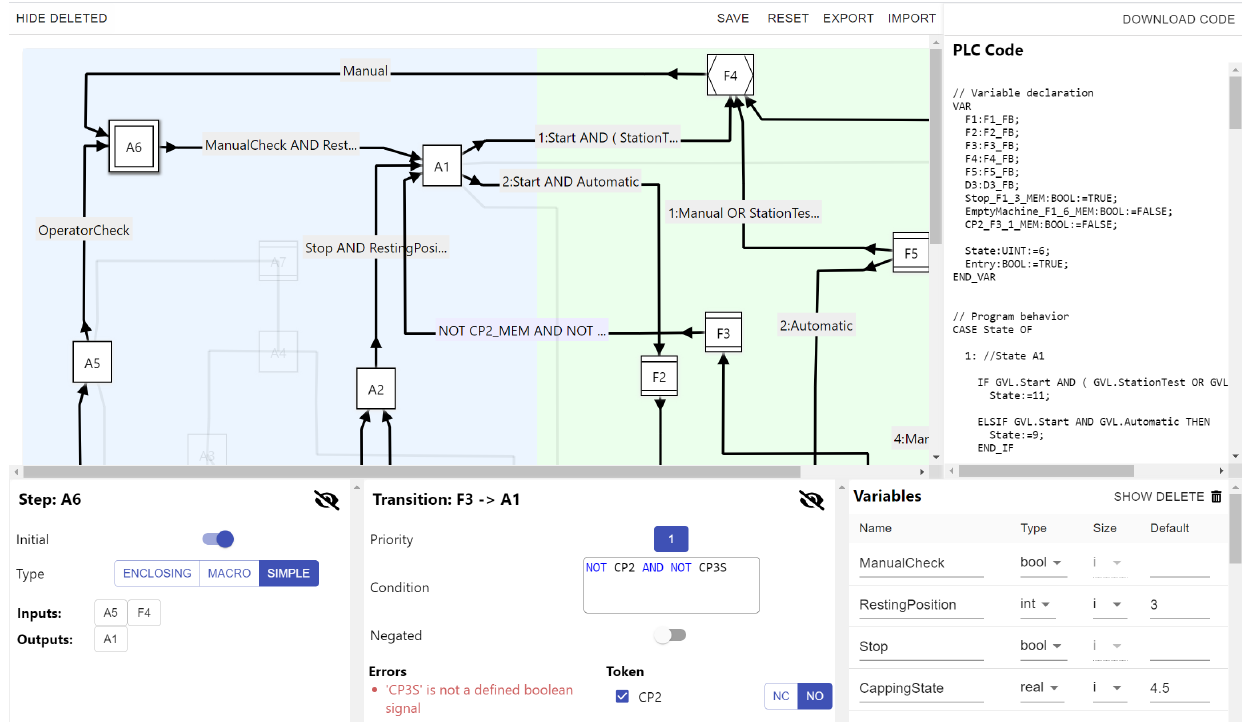
Figure 5. Web Application of the